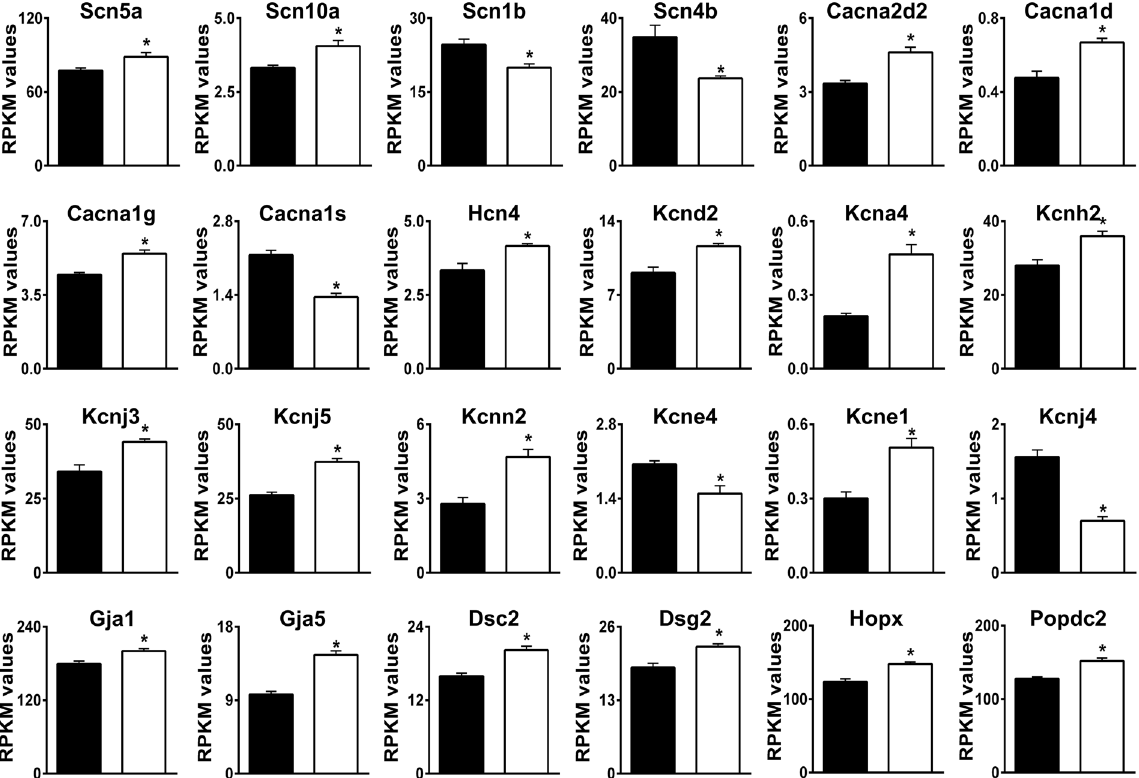
Figure 4. Differential expression of genes involved in membrane excitability and cardiac conduction. Genes relevant to these categories were identified by Gene Ontology analyses. RPKM values for WT (black bars) and AE3-null (white bars) hearts are shown. See Supplementary Information for detailed explanations and references for individual genes. The genes shown are a subset of 104 genes presented in Supplementary Table S5 and 84 transporter, pump, and channel genes in Supplementary Table S6; values are means ± SE; n = 4 for each genotype; * p ≤ 0.01 vs WT controls, except Kcne1 (p =